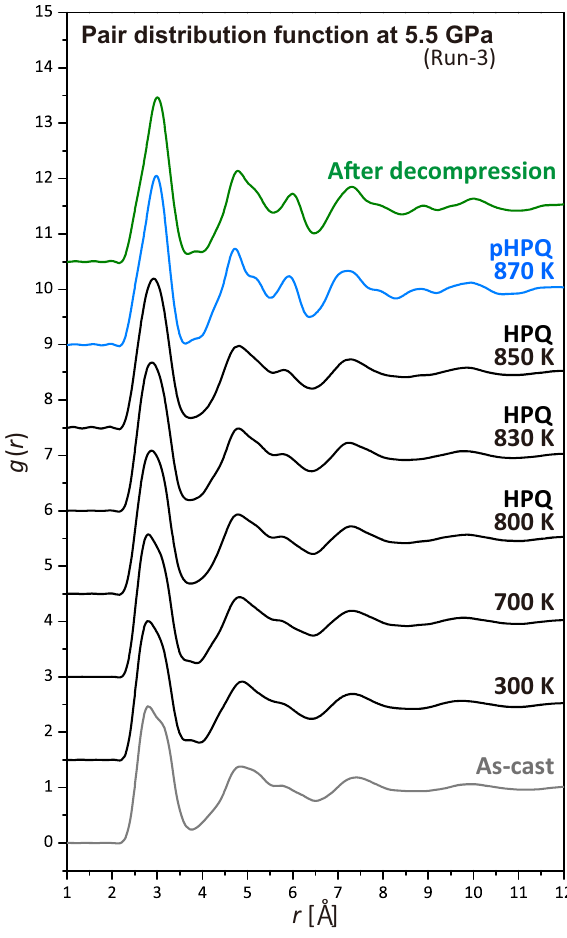
Fig. 3 Pair distribution functions g ( r ) of Zr 50 Cu 40 Al 10 BMG at 5.5 GPa. g ( r ) obtained from S ( Q ) at 5.5 GPa and after decompression (Run-3). Temperature values indicate synthesized temperature conditions. The data are shifted by 1.5 for clarity.